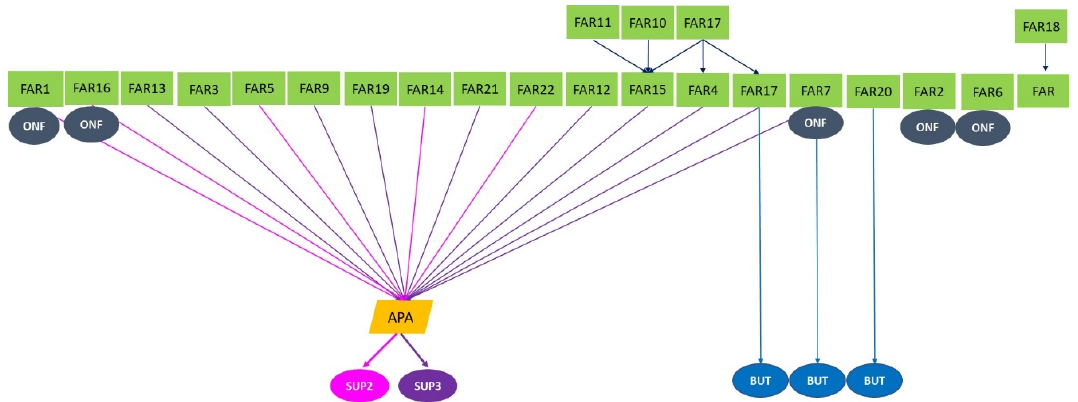
Figure 8. Food network detected in 2018: the sale of the production between farmers (FAR), supermarkets (SUP), butcheries (BUT), and on-farm direct sales (ONF).